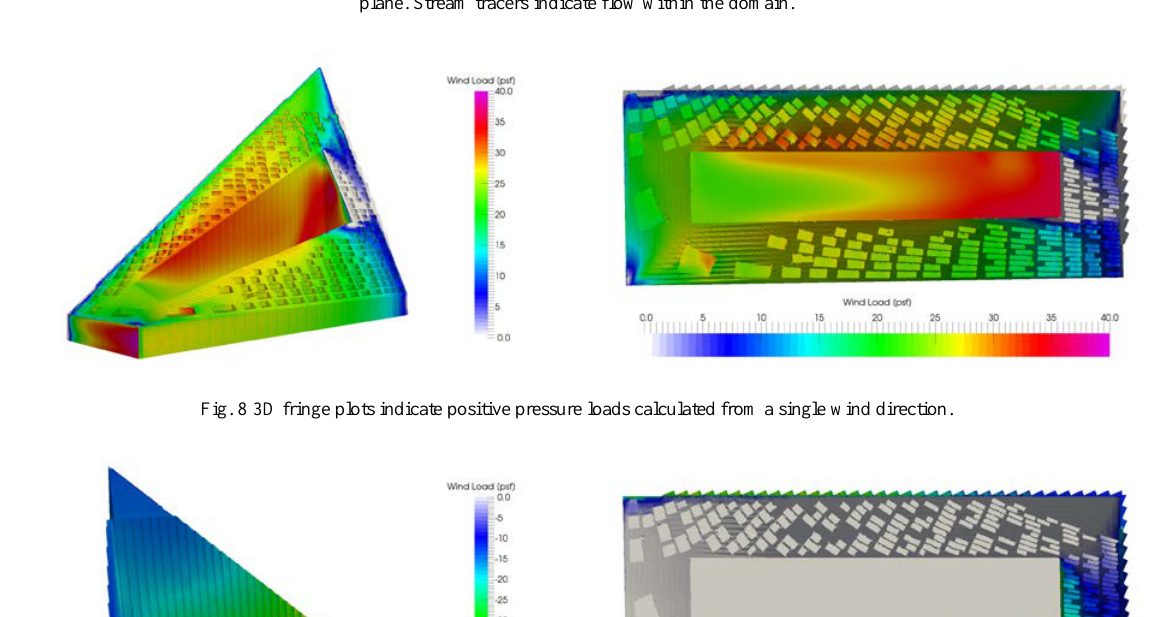
Fig. 7 Calculation outputs. Pressure loads shown on the building exteriors (red – positive, blue – negative) Velocity fringe shown on the ground plane. Stream tracers indicate flow within the domain.